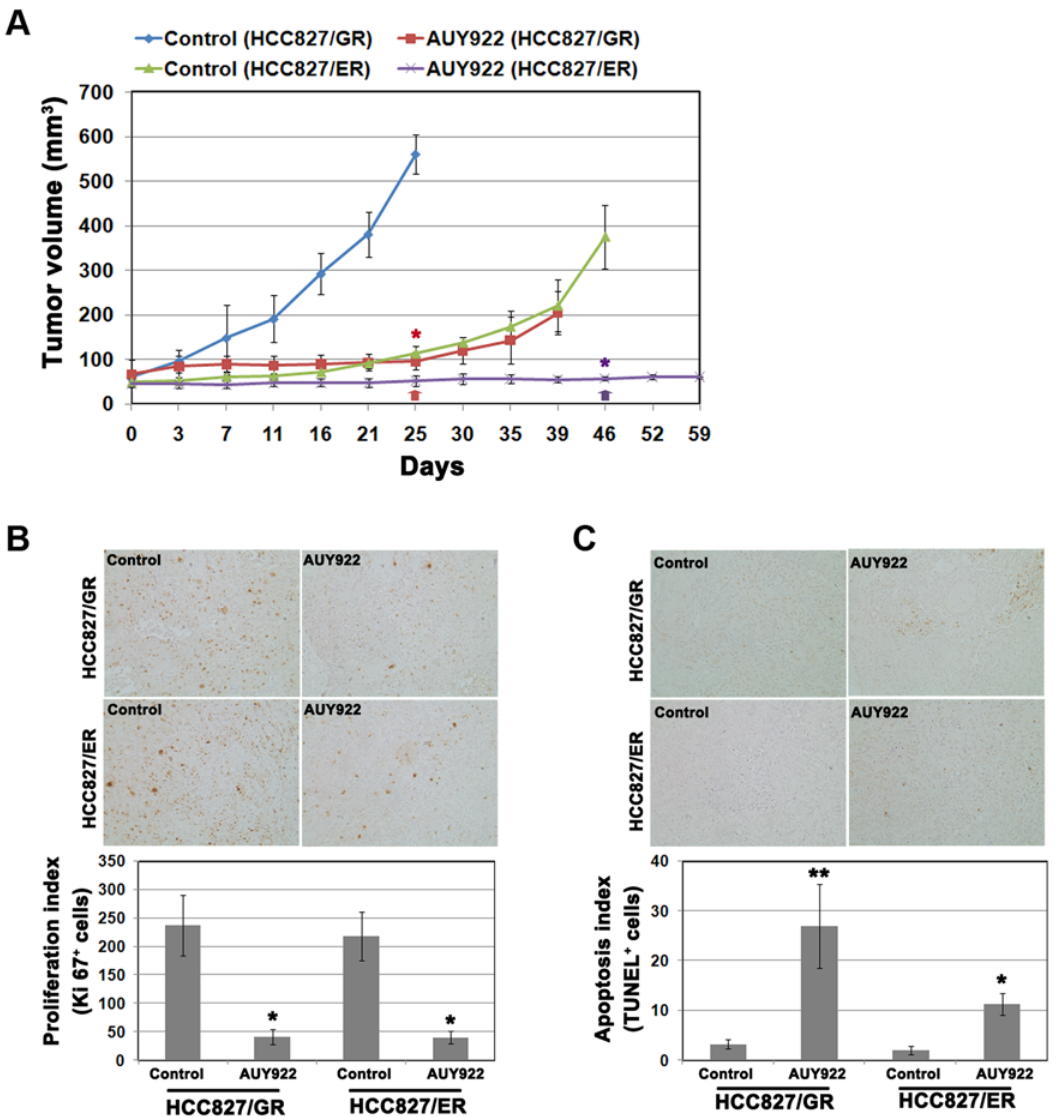
Fig 4. Efficacy of AUY922 in HCC827/GR and HCC827/ER tumor xenograft models. A , SCID mice with established HCC827/GR and HCC827/ER tumor cell xenografts were treated with AUY922. Tumor size was measured on the indicated days, and tumor volume was calculated. Arrows mean last day of drug treatment (red arrow, HCC827/GR; purple arrow, HCC827/ER). Bars represent the mean tumor volume ± SD. B and C , Immunohistochemical staining for Ki-67 and TUNEL followed by quantitative analysis of proliferation and apoptosis in (B) Ki-67 + cells and (C) TUNEL + cells. * p < 0.01 and ** p < 0.001 in comparison with the